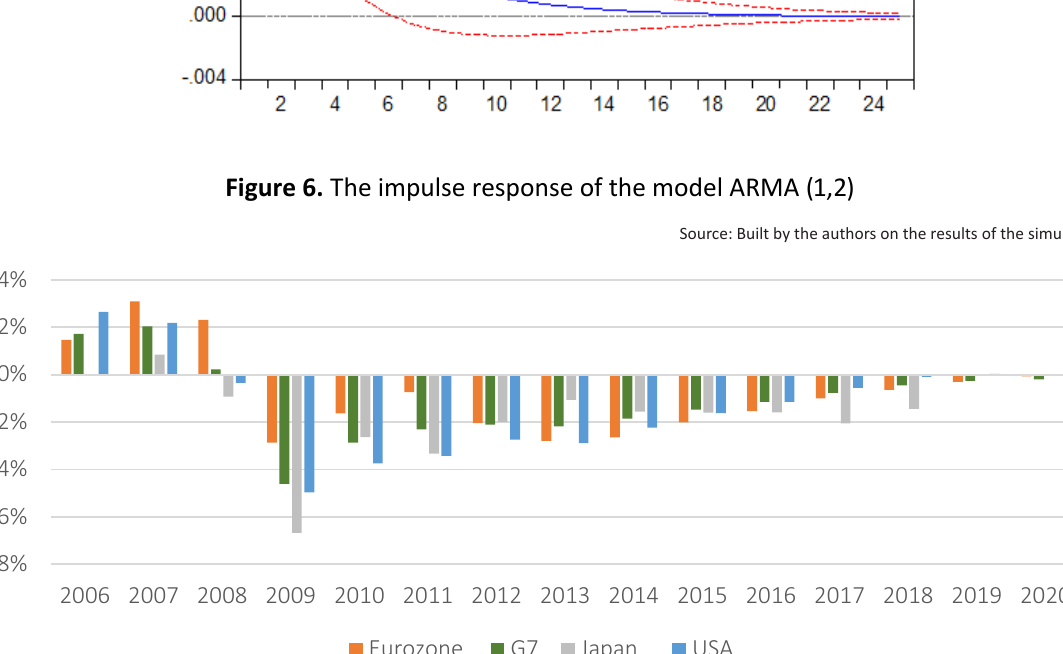
Figure 7. Estimation of breaks of GDP gaps for the countries of the world